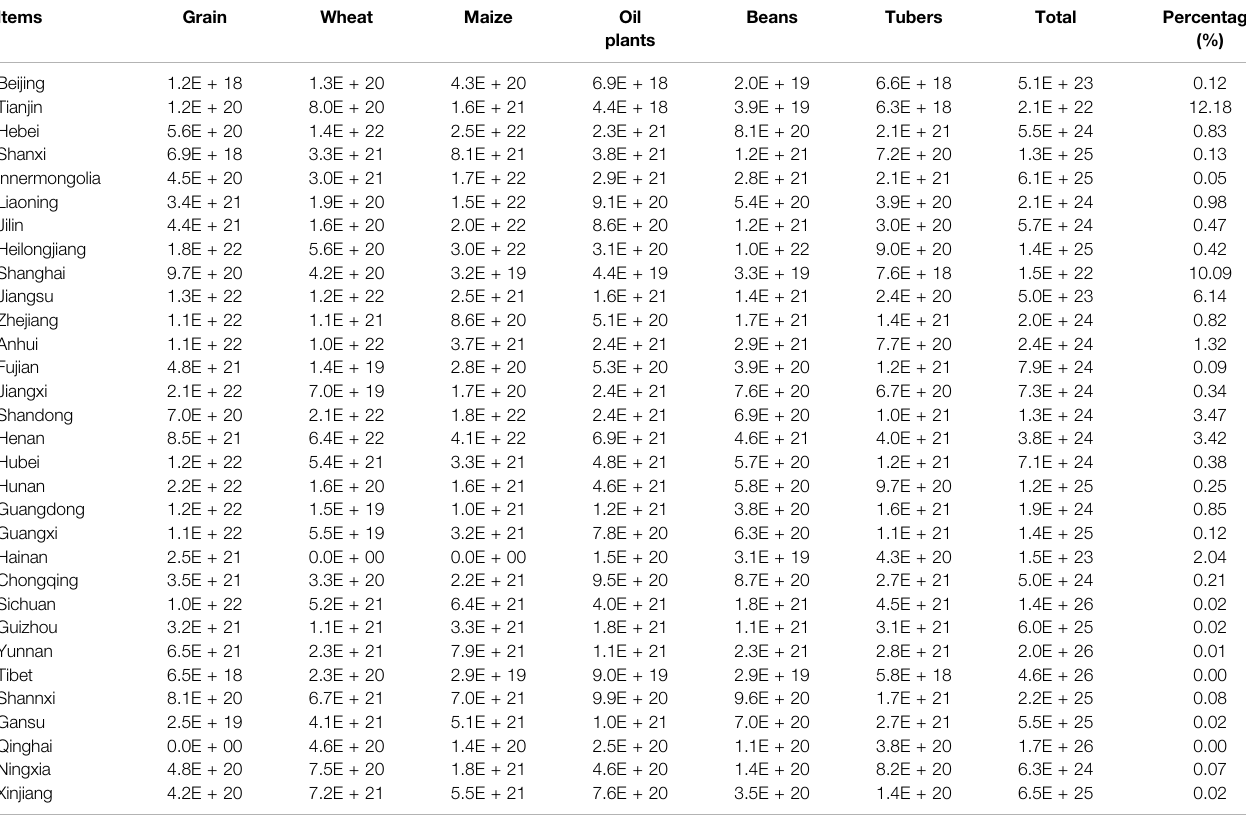
TABLE 5 | The renewable inputs of each province and agri-products. Items Grain Wheat Maize Oil